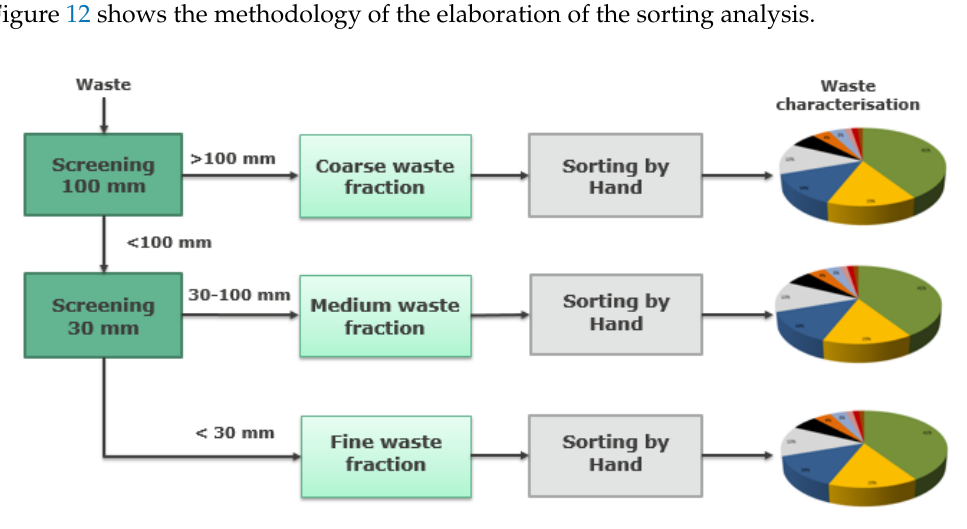
Figure 12. Sorting analysis methodology.